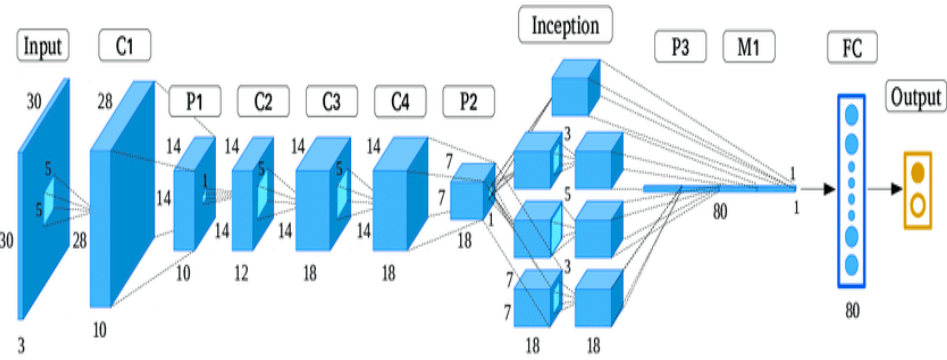
Figure 7. GoogleNet architecture.